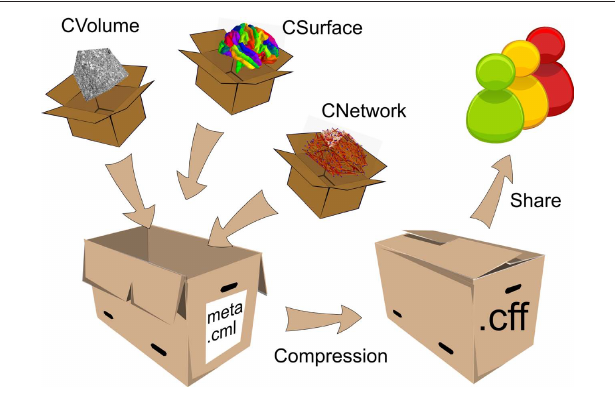
Figure 1 | general processing stages of a connectome workflow. The Connectome Viewer Toolkit currently supports the workflow highlighted in yellow. Mapping streams for structural data, such as the Connectome Mapper, or functional data may converge to a connectome file and can be further managed, analyzed, and visualized with the Connectome Viewer. Connectome files may be reused in other frameworks for analysis and visualization tasks.